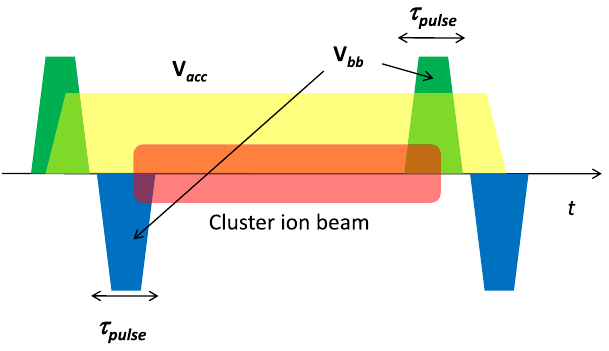
FIG. 12. Barrier voltage pulses for confinement, acceleration voltage pulse, and trapped ion